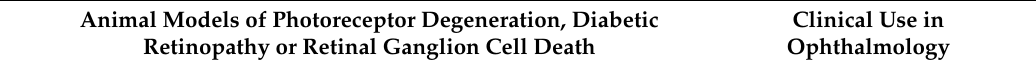
Table 1. Antioxidant, antiapoptotic and anti-inflammatory compounds with demonstrated efficacy in retinal disease. The table compiles proven therapeutic interventions for inherited and induced retinal damage